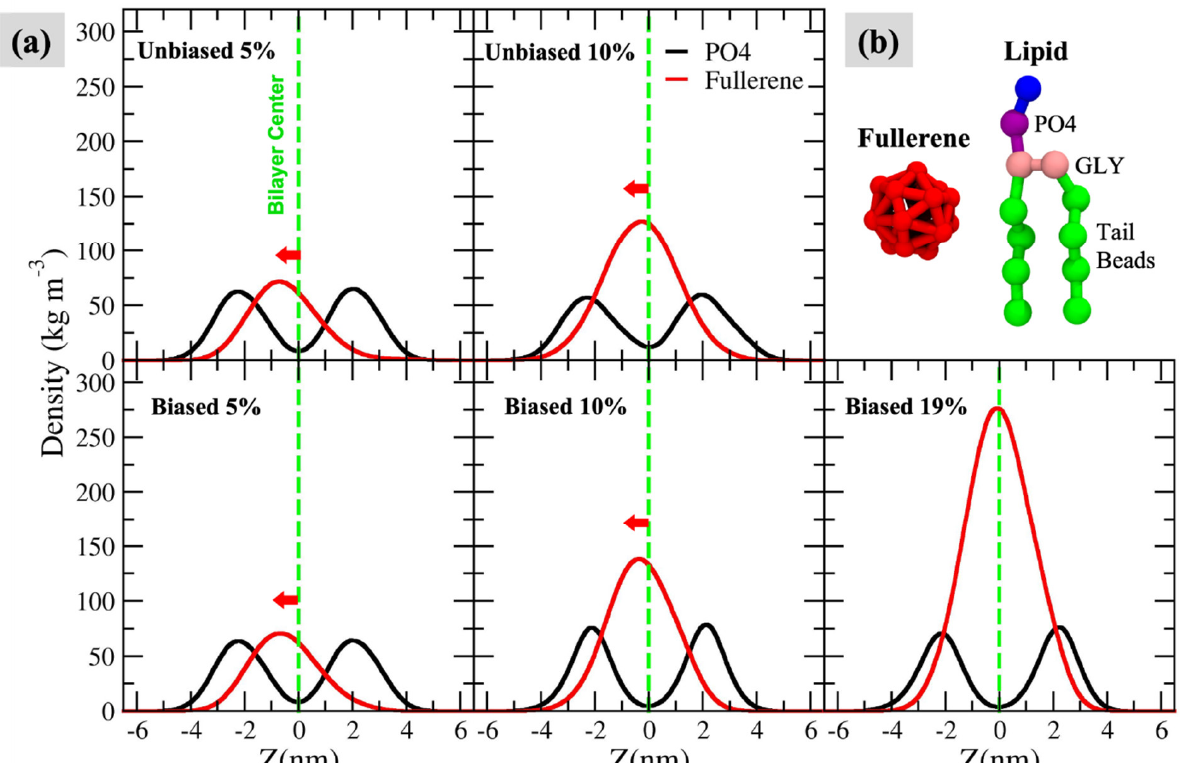
Figure 2. ( a ) Density distribution profiles of the phosphate groups (PO4 beads) and fullerenes in the z-direction for biased and unbiased simulations at fullerene concentrations of 5%, 10%, and 19%. The dashed lines represent the bilayer center (z = 0 nm). The data of biased and unbiased simulations with fullerene concentrations of 20% and 30% are not presented because the plasma membranes were unable to maintain the bilayer structure. ( b ) The MARTINI coarse-grained (CG) models of fullerene and lipid.